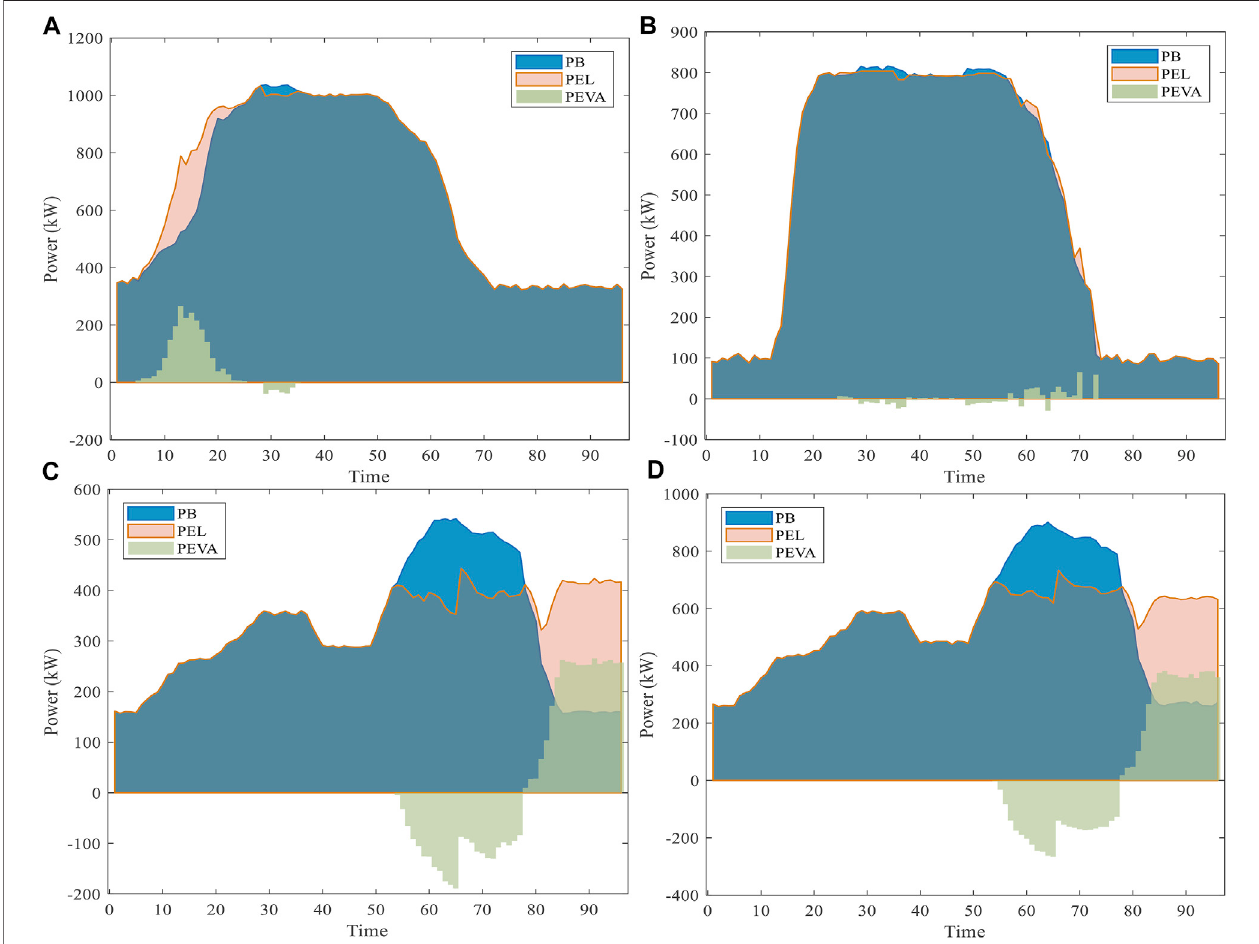
FIGURE7|(A) Of fi ceregioncalculationresults. (B) Businessregioncalculationresults. (C) Homeregion1calculationresults. (D)